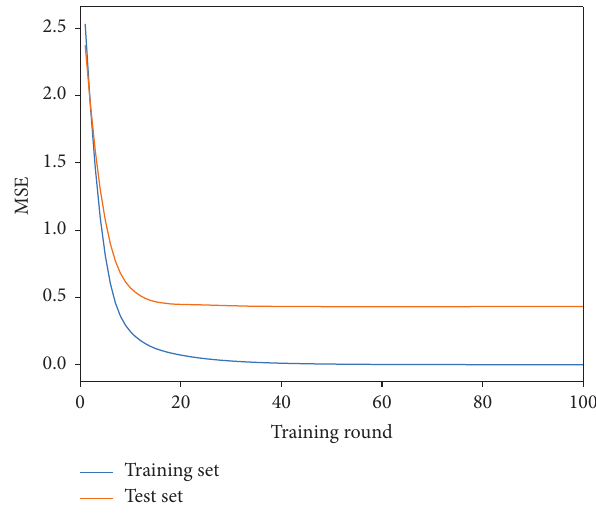
Figure 1: MSE on different data